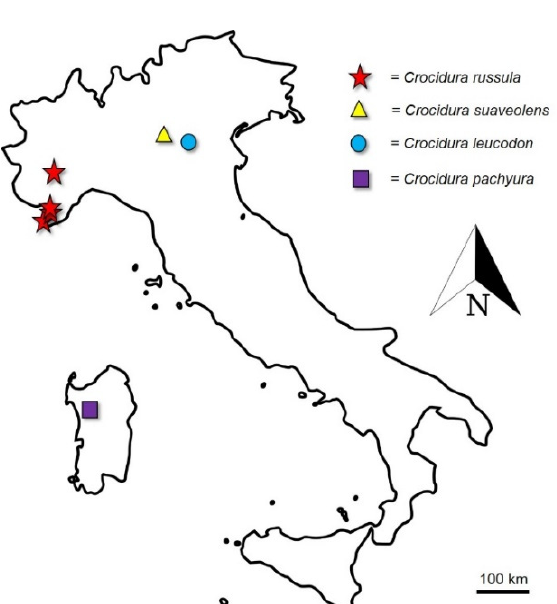
Figure 1. Locations of origin of Crocidura samples used in our study (Italy).